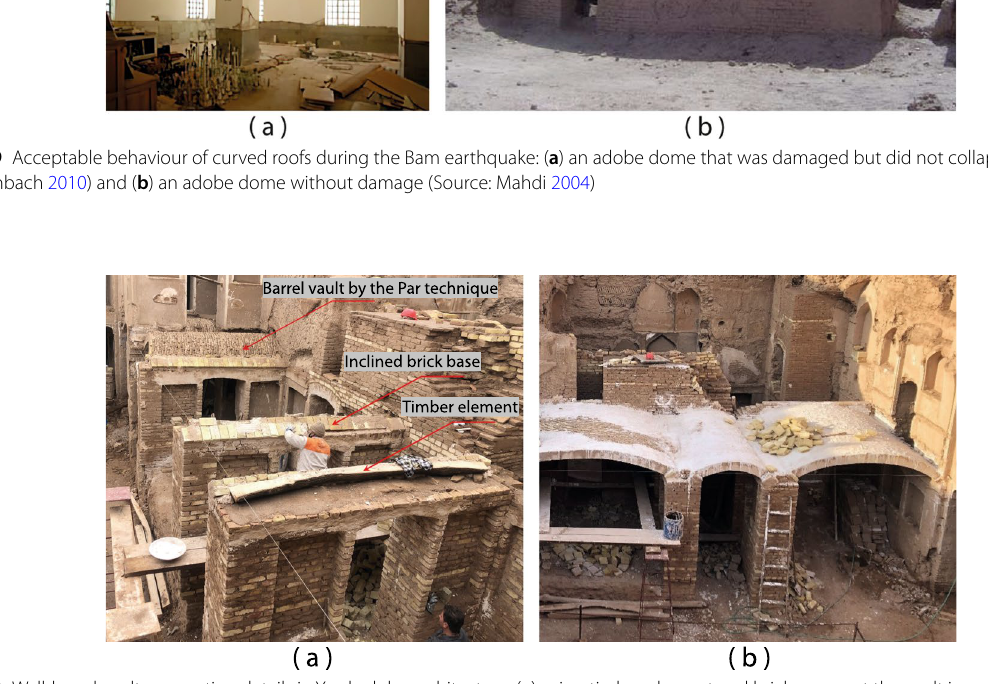
Fig. 20 Wall‑barrel vault connection details in Yazd adobe architecture: ( a ) using timber element and brick course at the vault impost and ( b ) finishing by the application of gypsum grout (Source: Ehsan Raad, during reconstruction work on the Mortaz